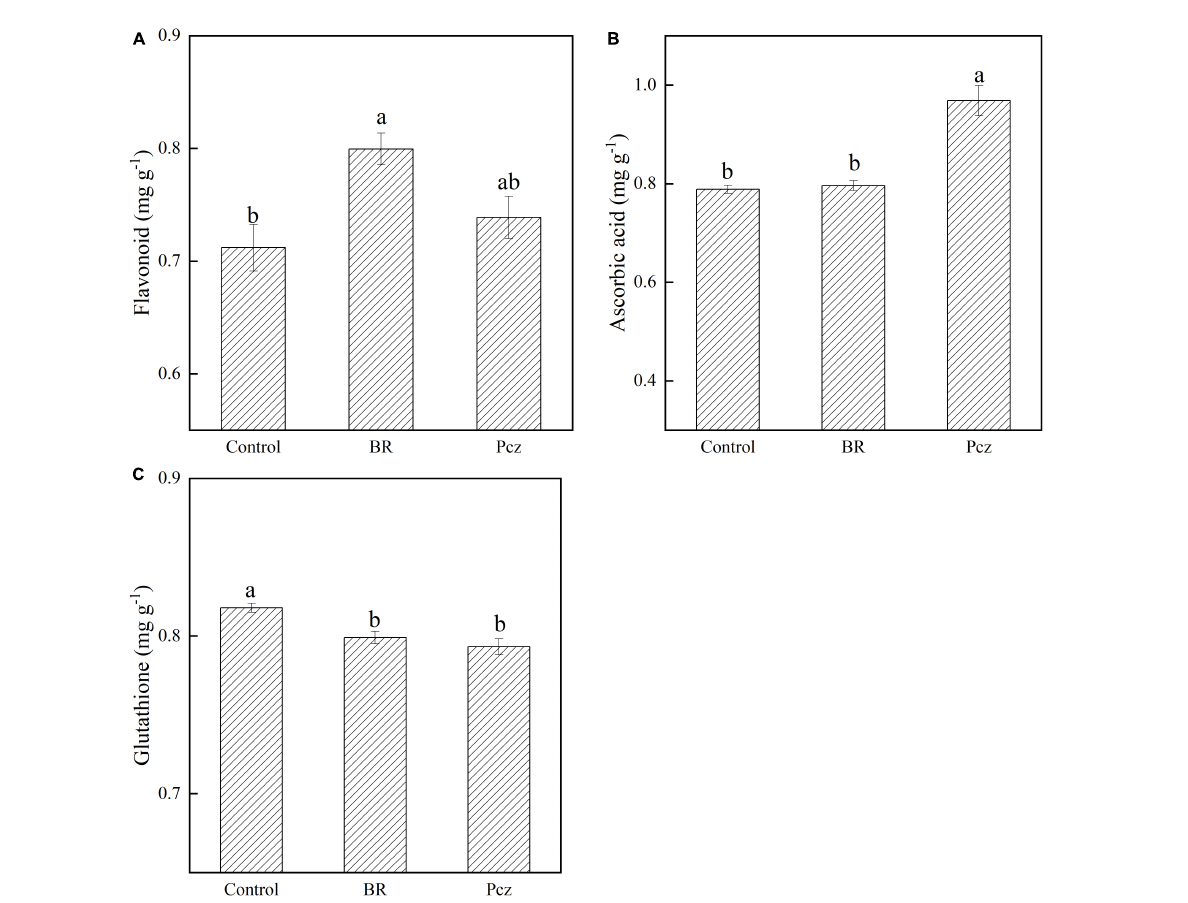
FIGURE1 Flavonoid (A) , ascorbic acid (B) , and glutathione (C) content in bulbil of P. ternata under BR and Pcz treatments. The bars with different letters are significantly different from each treatment ( p < 0.05). Values are means of four replicates ±